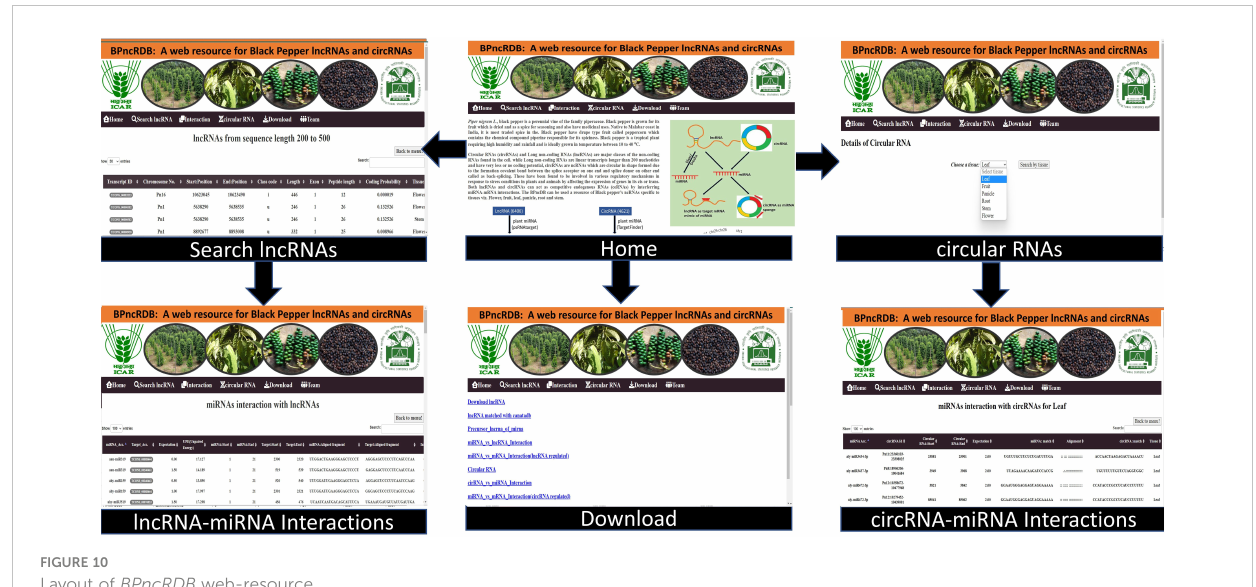
FIGURE 10 Layout of BPncRDB